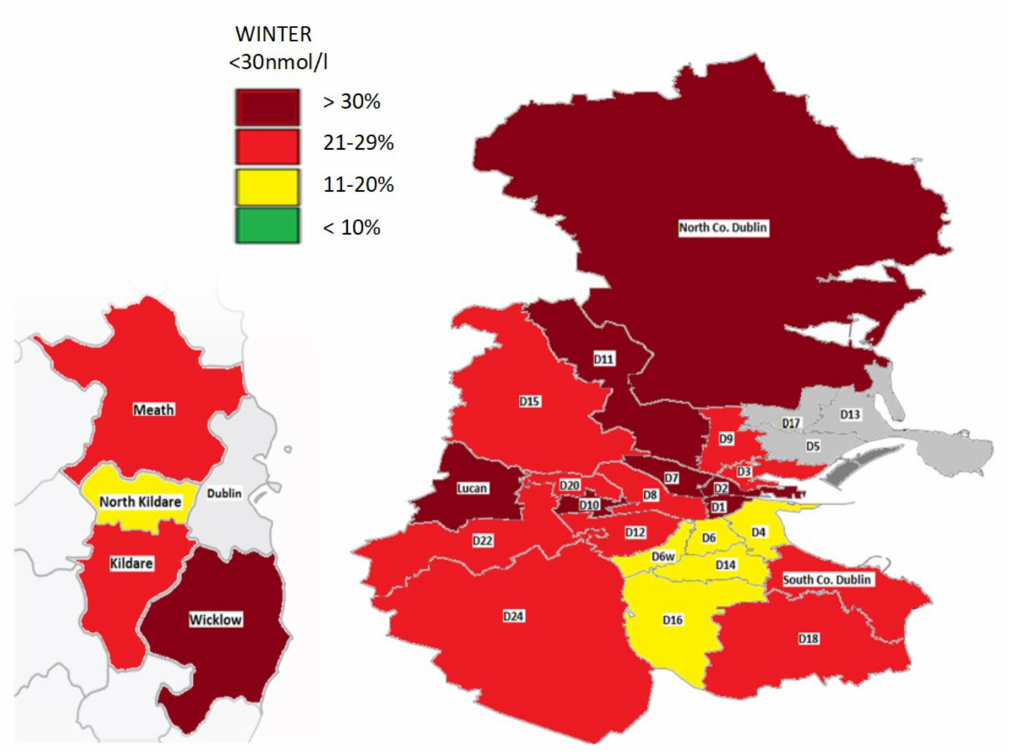
Figure 3. Geomap of 25(OH)D status in Dublin and surrounding counties in winter. Areas with insu ffi cient numbers ( < 120) for analysis are shown in grey.